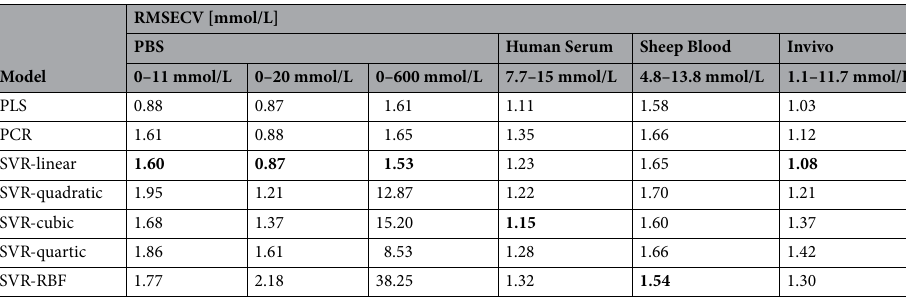
Table 1. The comparison of pls, pcr and svr models with diefferent kernel functions in different